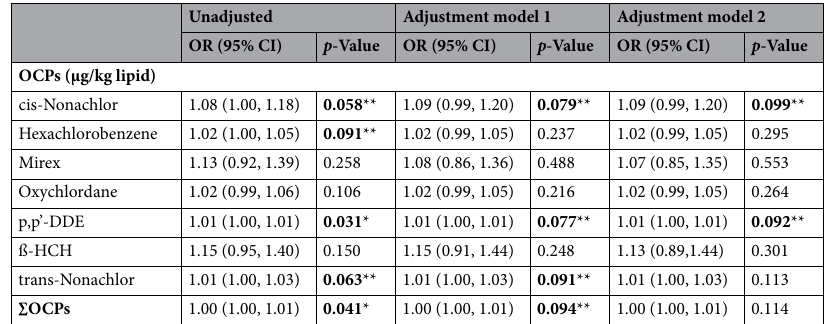
Table 6. Logistic regression analysis of associations between continuous prenatal OCP exposure and abnormal SDQ score: Greenlandic children 3–5 years of age born 2014–2016, the ACCEPT birth cohort. Normal/borderline n = 84, Abnormal n = 11, OR odds-ratio, CI confidence interval, Bold text and * = Significant ( p ≤ 0.050), Bold text and ** = Borderline significant ( p ≤ 0.100), Adjustment model 1: Maternal plasma cotinine, maternal educational level, maternal age at delivery, Adjustment model 2: Adjustment model 1 + breast-feeding duration, OCPs Organochlorine pesticides.